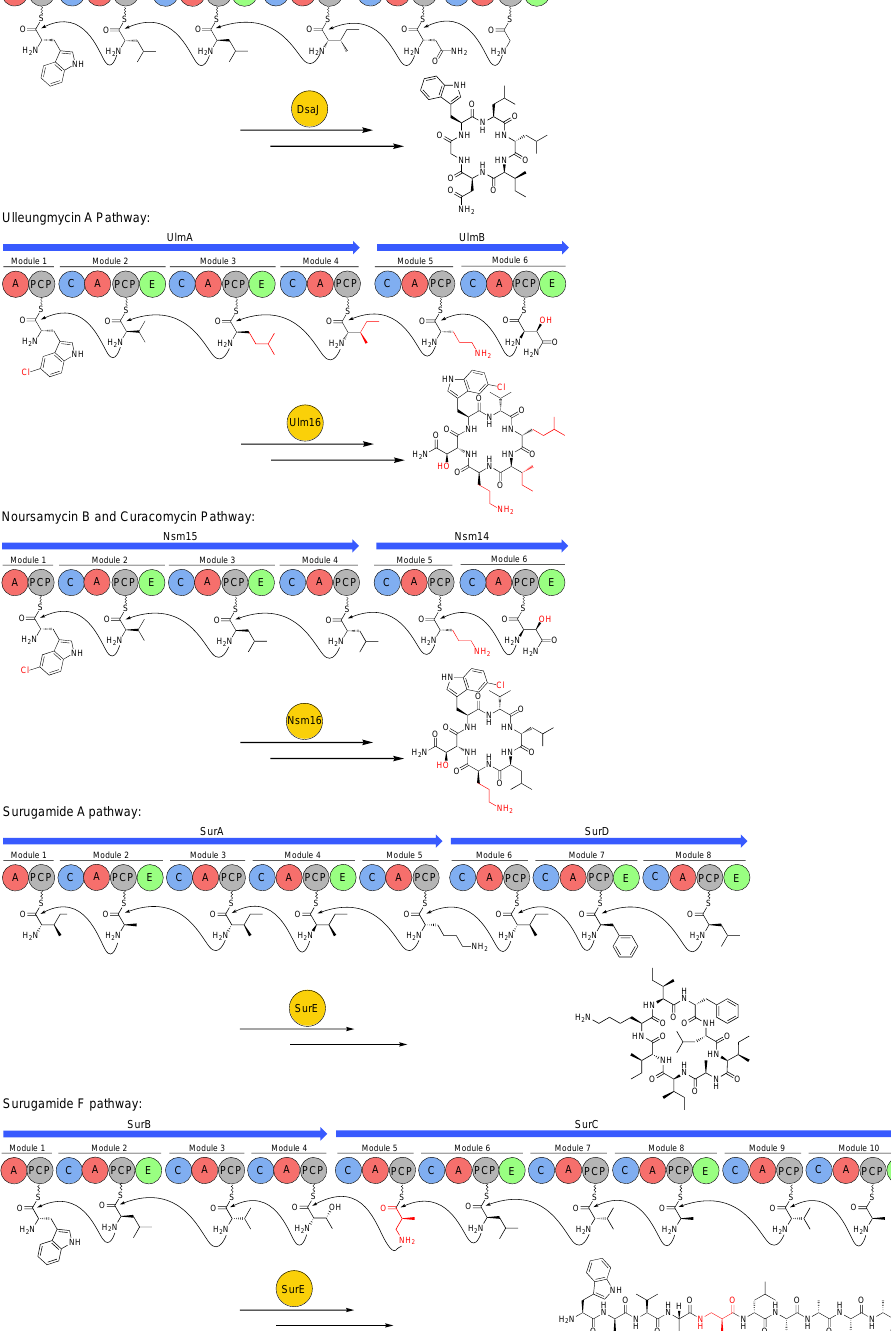
Figure 3. Biosynthetic pathways of the desotamide family of antibiotics. Red colouring denotes biosynthetic precursors discussed in Section 4. A = adenylation domain, PCP = peptidyl carrier protein, C = condensation, E = epimerase. The biosynthesis of desotamide A, ulleungmycin A, noursamycin B or curacomycin, surugamide A and surugamide F is shown.